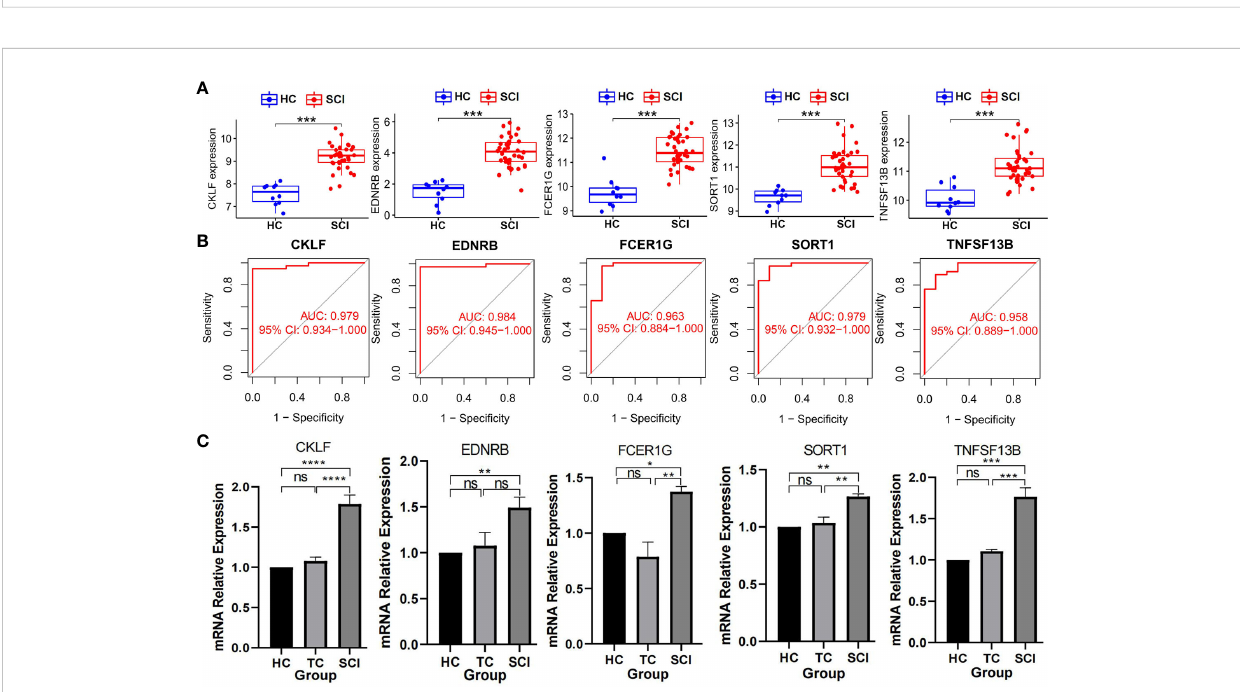
FIGURE 4 Detection of biomarkers of SCI. (A) Expression of biomarkers between SCI group and HC group in data set. ***P<0.005; A P value <0.5 was regarded as statistically signi fi cant. (B) AUC values of the biomarkers. (C) Expression levels of biomarkers detected by qPCR. Values are expressed as the means±SEM. n=3 for each group. Student ’ s t-test was used. ****P < 0.0001; ***P < 0.001; **P < 0.01; *P < 0.05; ns, no signi fi cance. A P value <0.05 was regarded as statistically signi fi cant. SCI, spinal cord injury; HC, healthy uninjured control; TC, trauma control with noncentral nervous system injury; AUC, area under the curve; qPCR, quantitative polymerase chain